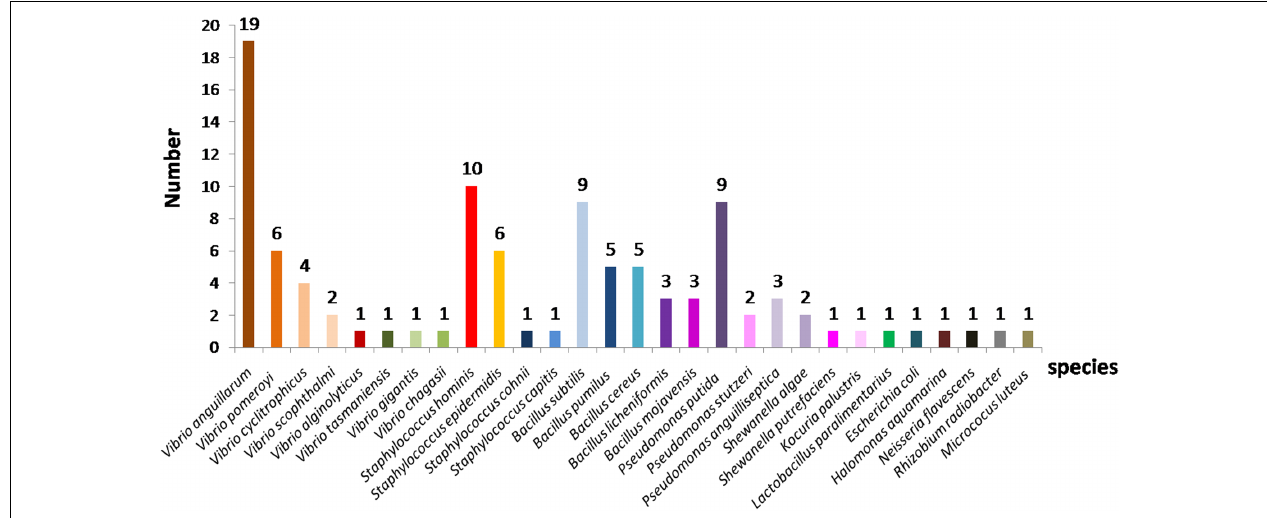
FIGURE 1 | Species distribution of bacterial strains identified by MALDI-TOF mass spectrometry isolated from copepod eggs of Acartia tonsa .